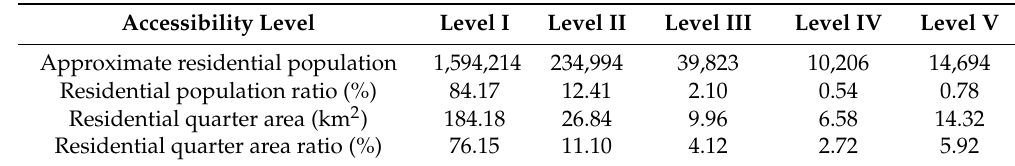
Table 4. Statistical table of greenway accessibility